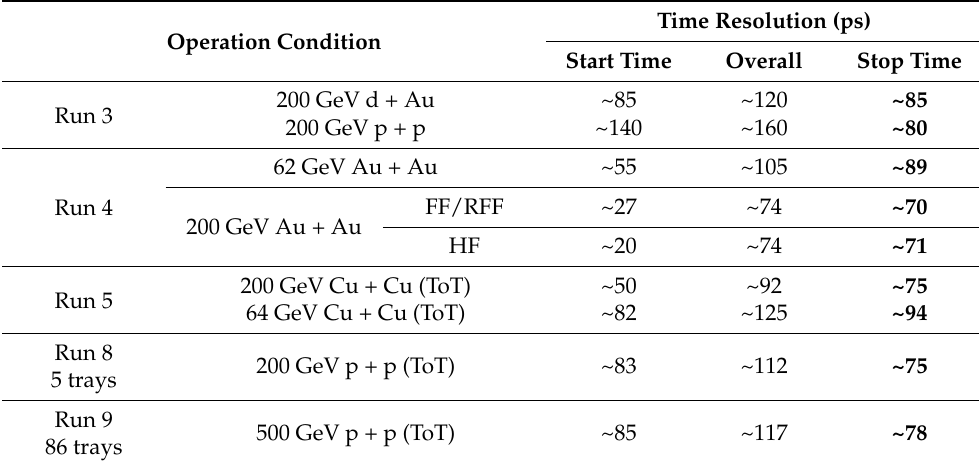
Table 1. The time resolutions of the STAR MRPC during different physics runs. The stop times in bold text are provided by the ToF system.